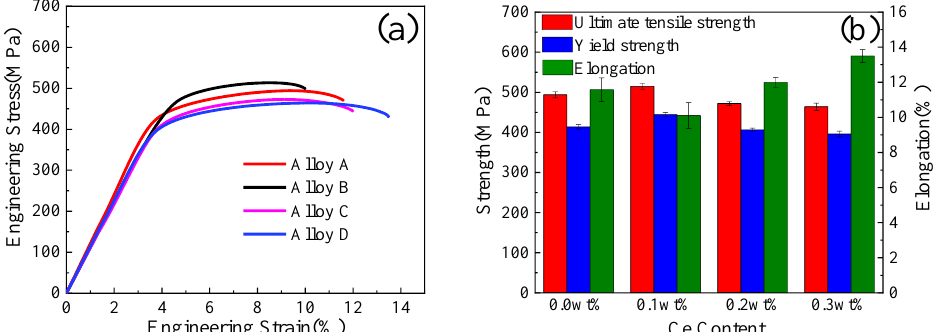
Figure 13. Tensile test of the alloys after T6 treatments. ( a ) Engineering stress–strain curves; ( b ) Tensile properties curves.